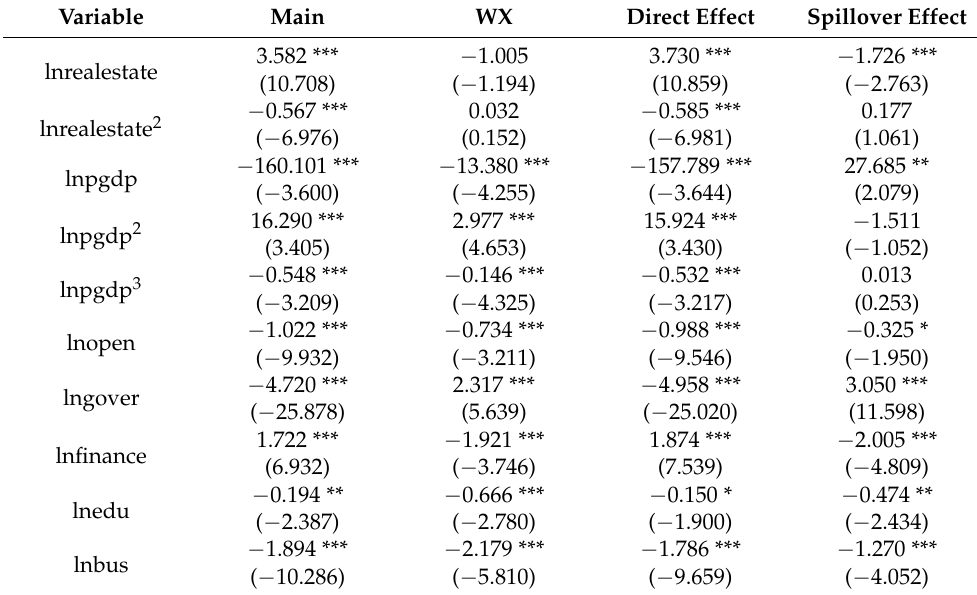
Table 4. Regression results of